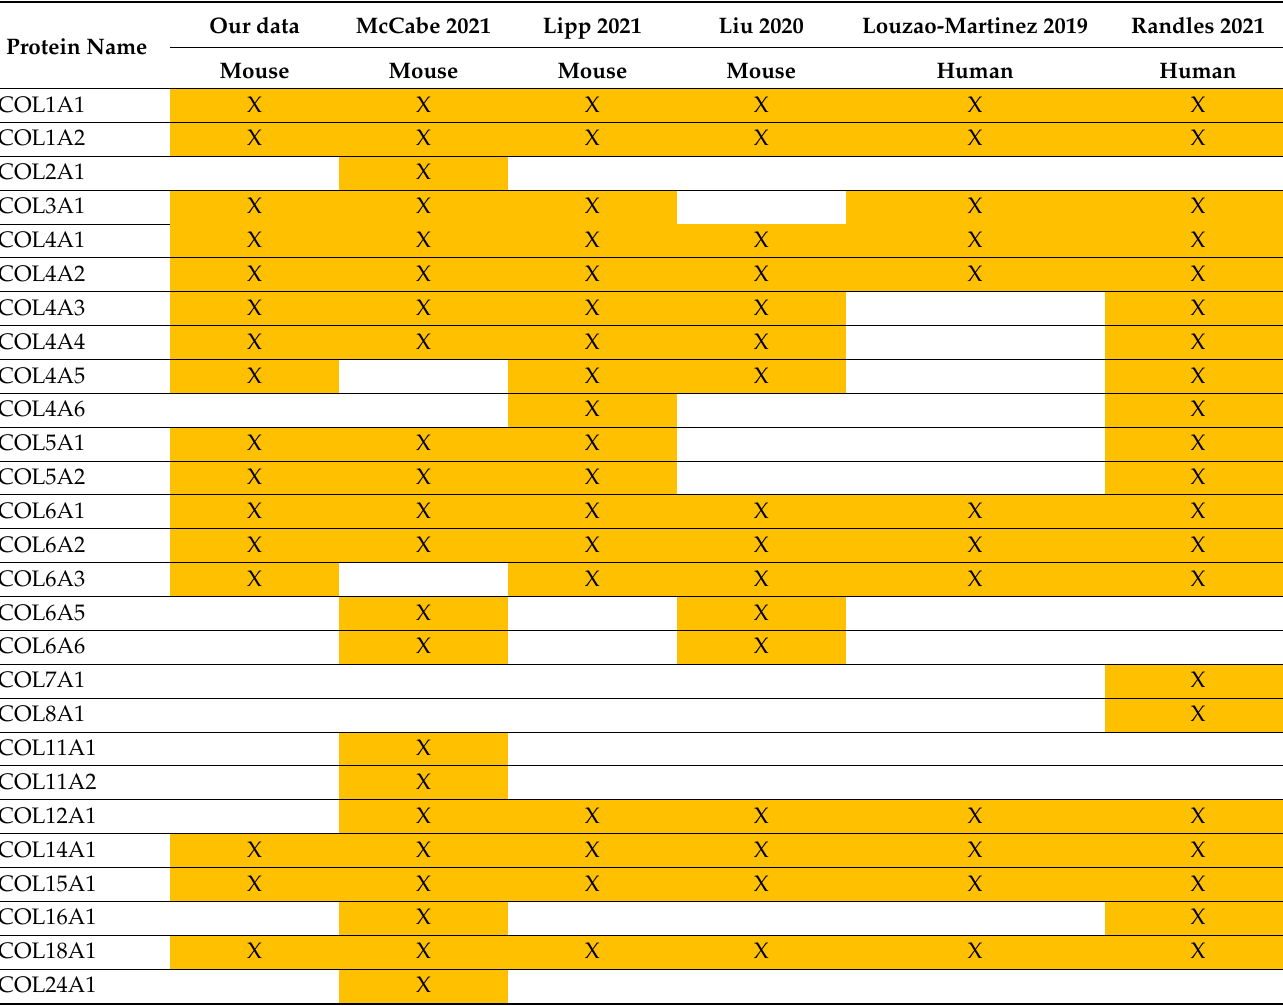
Table A10. The combined list of core matrisome proteins belonging to the category of collagens and identified in mouse and human kidneys. The mouse matrisome proteins were obtained from our data and extracted from references [20,28,30]. Human matrisome proteins were obtained from the studies [31,32]. Highlighted “X” refers to identified protein in the corresponding study.